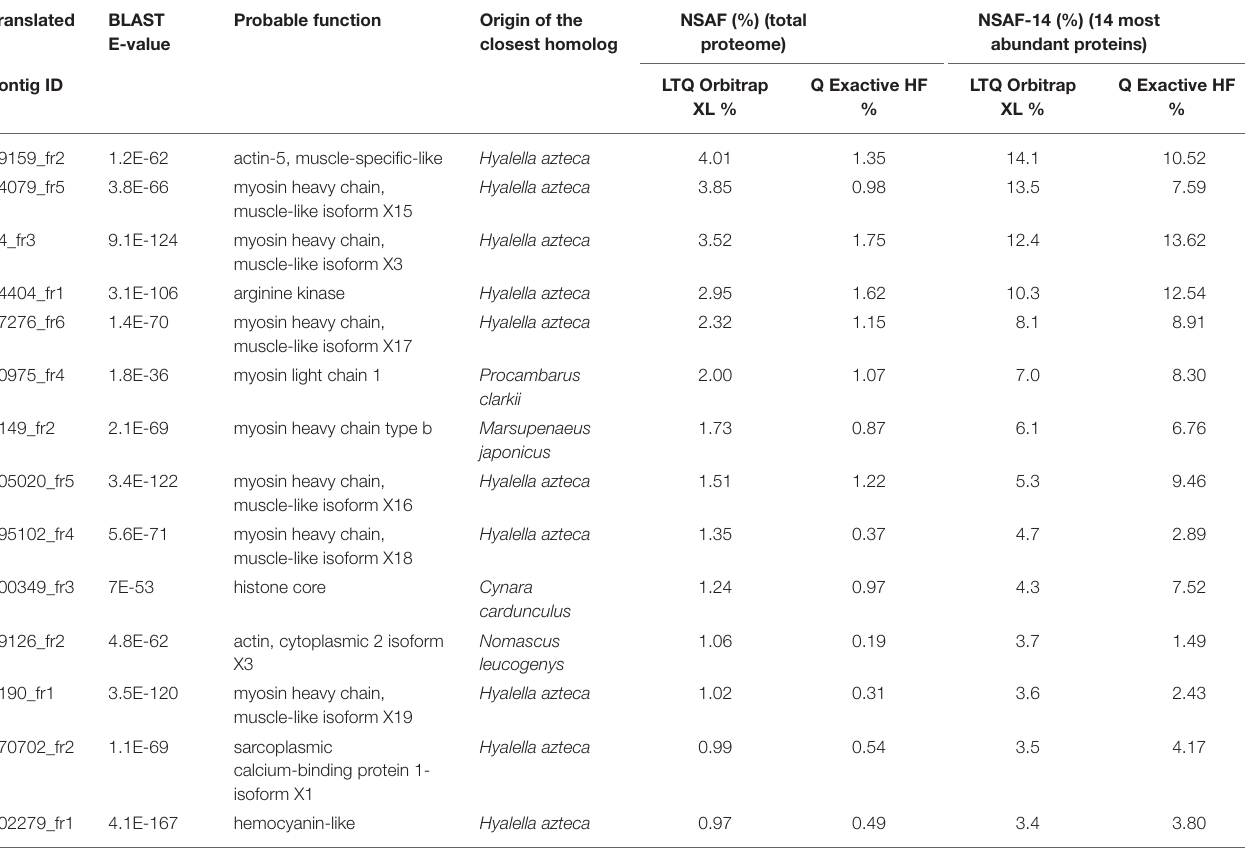
TABLE 2 | List of the most abundant proteins in the total proteome identified by the LTQ Orbitrap XL and by the Q Exactive HF instruments.